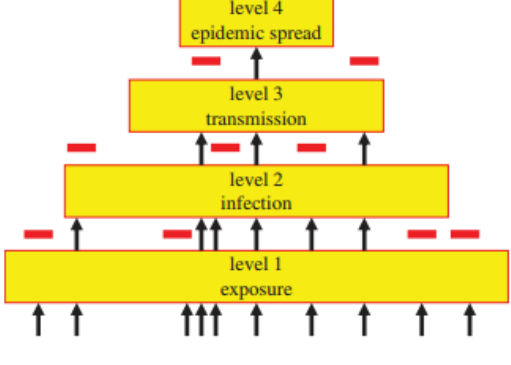
Fig 1. Pathogens Pyramid (Woolhouse et al.,